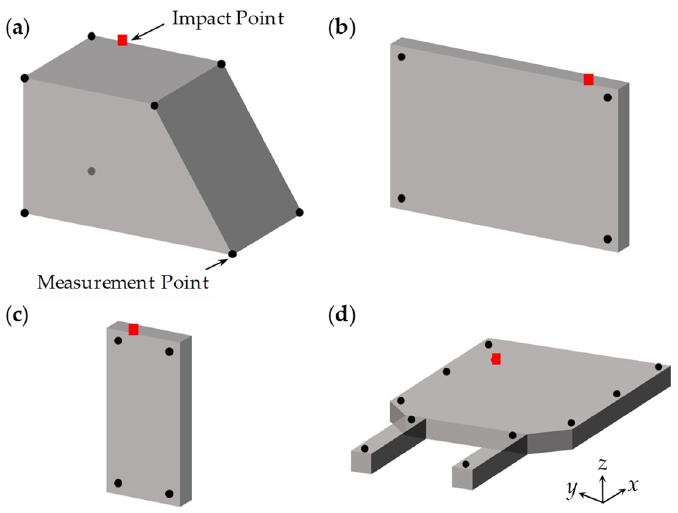
Figure 6. Impact and measurement points for the experimental modal tests: ( a ) powertrain; ( b ) radiator; ( c ) intercooler; and ( d ) body floor.